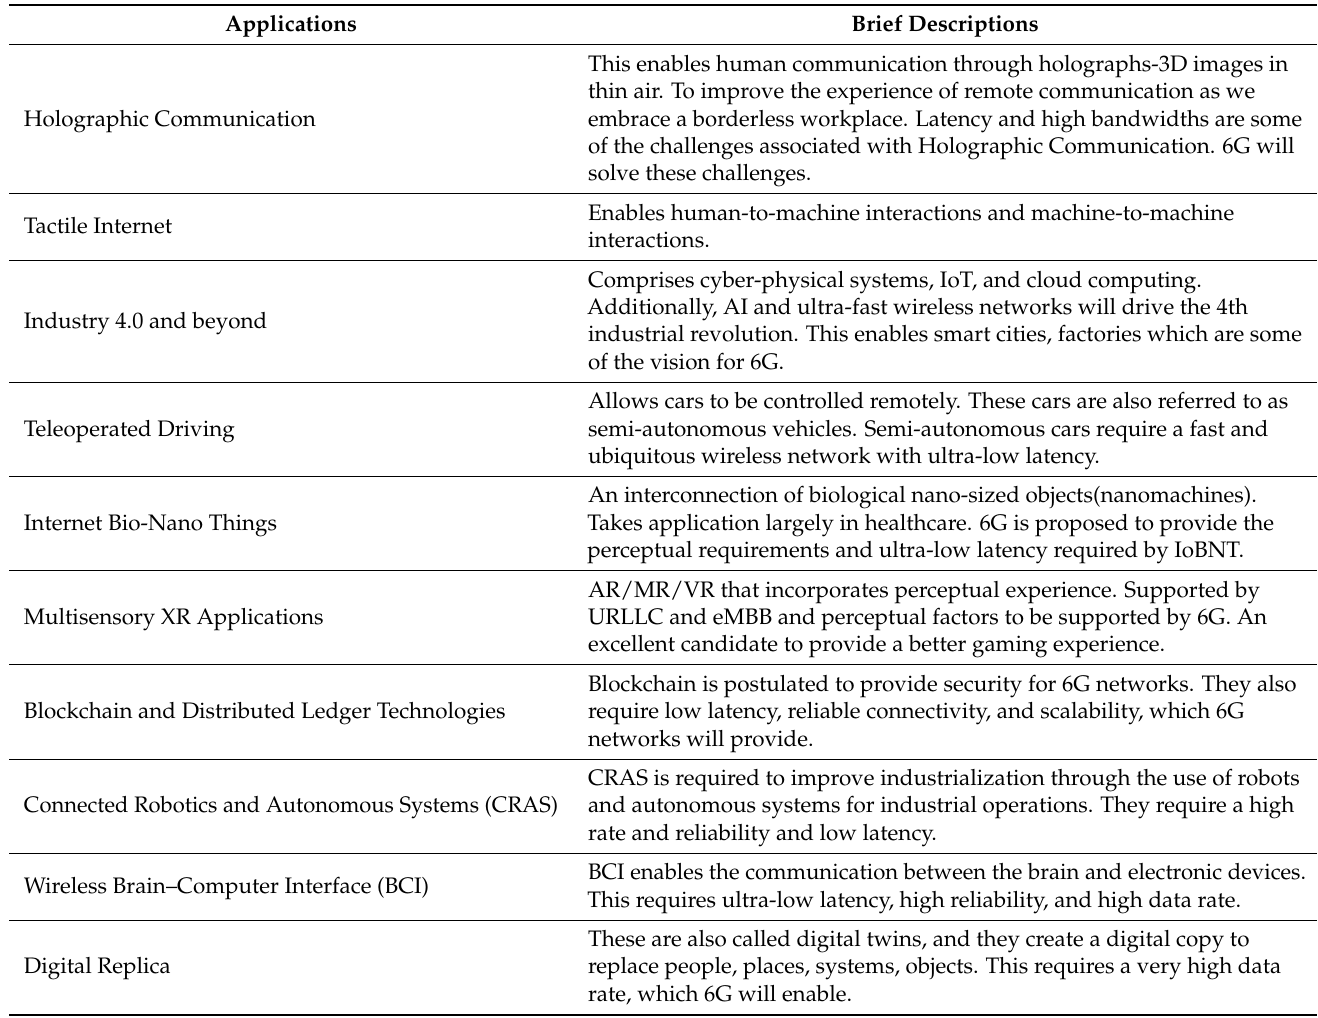
Table 15. Brief description of 6G